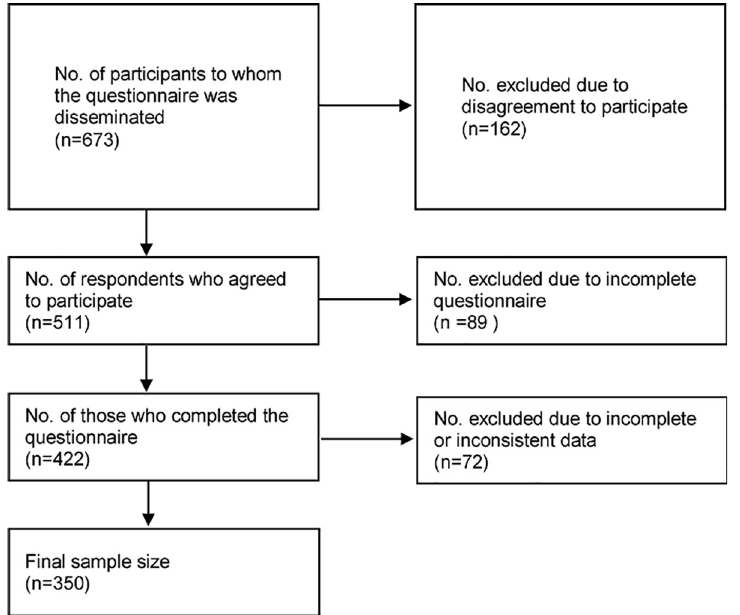
Fig 1. Flow chart of the study population to validate the 5C